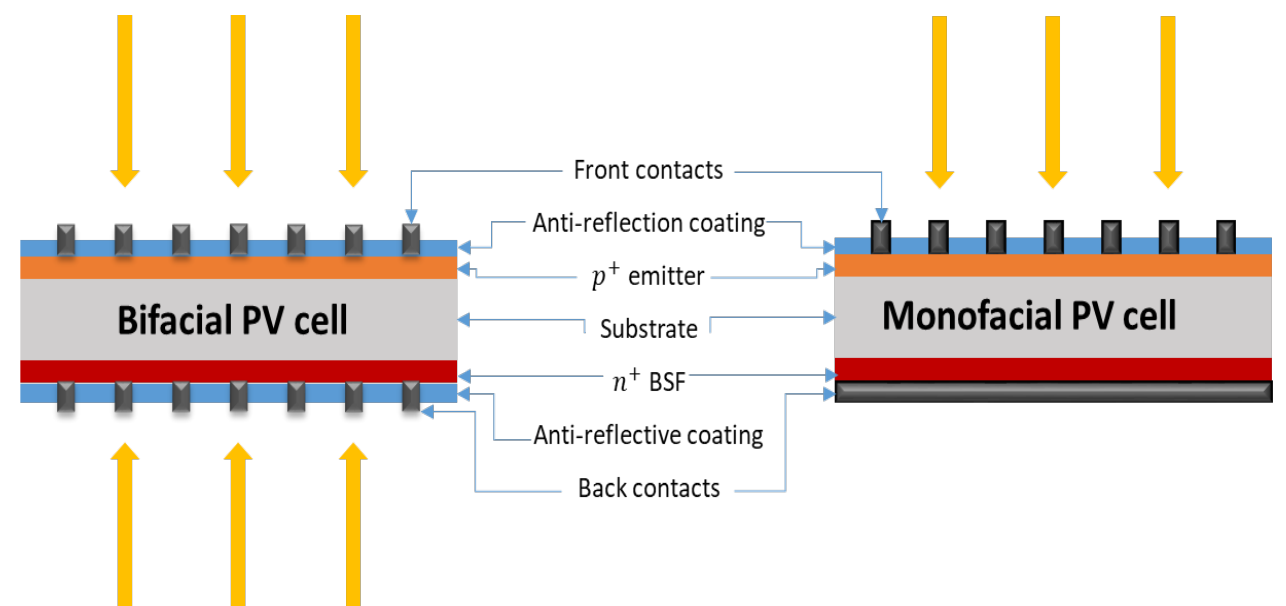
Figure 2. Structure and configuration of bifacial and monofacial photovoltaic cells (adapted from [24]).